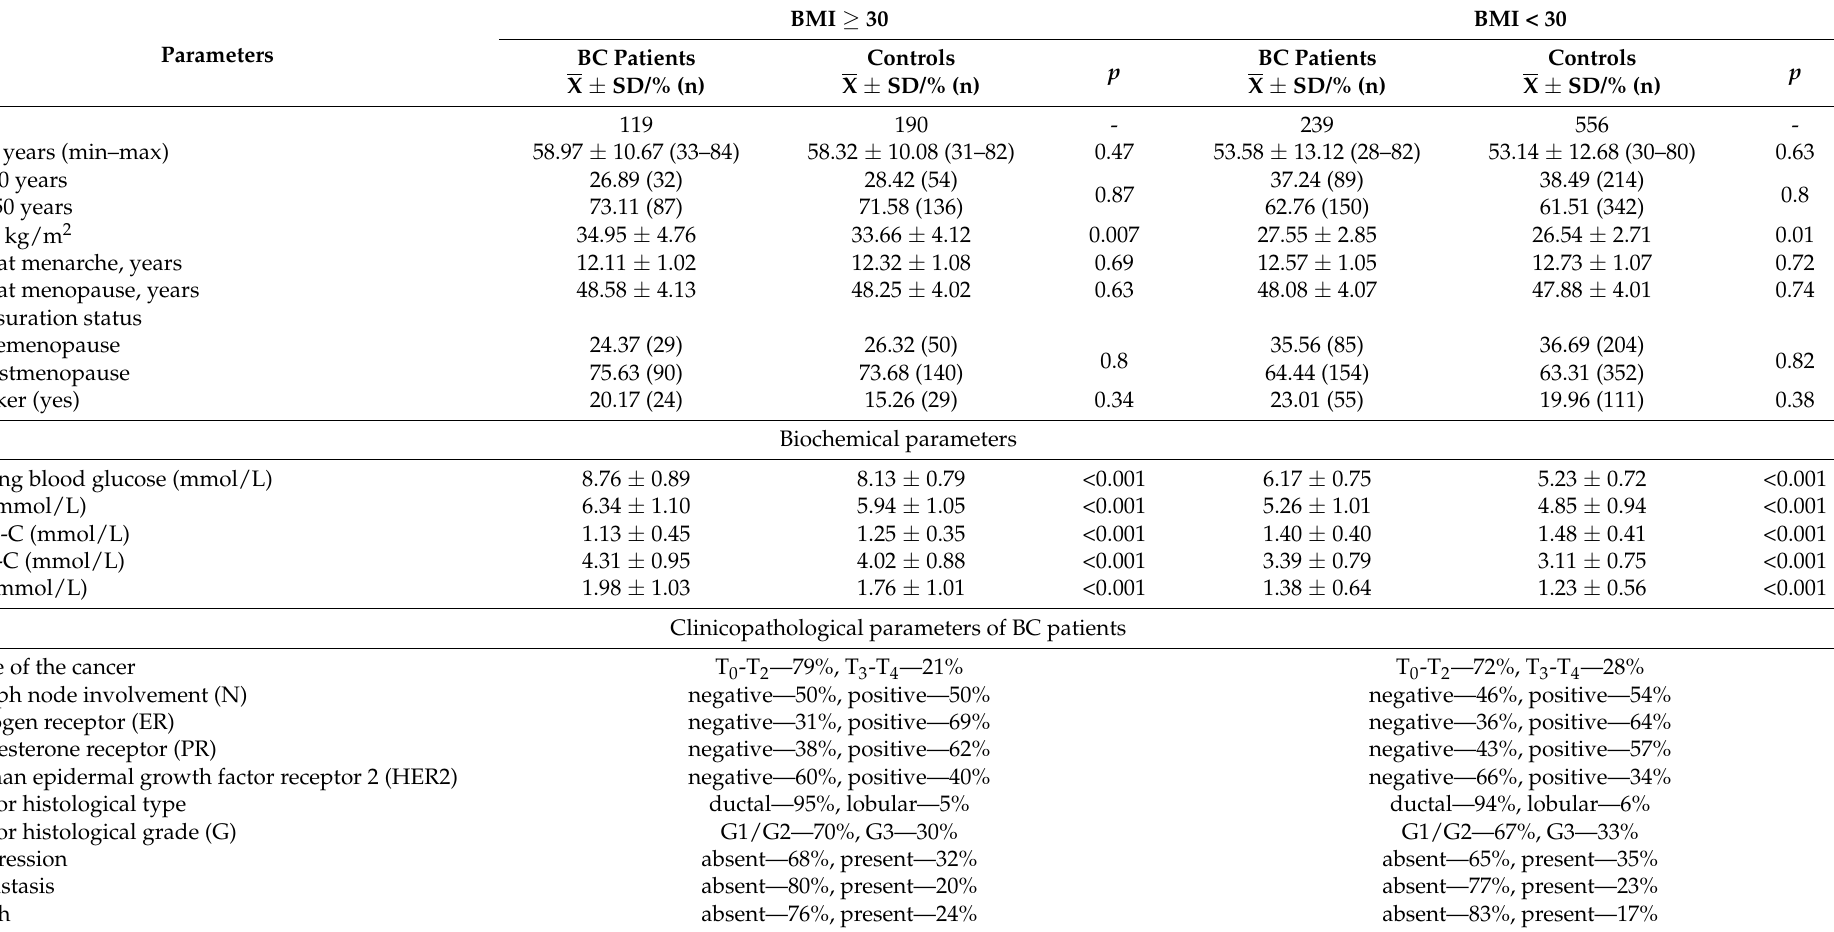
Table 1. Phenotypic characteristics of the study